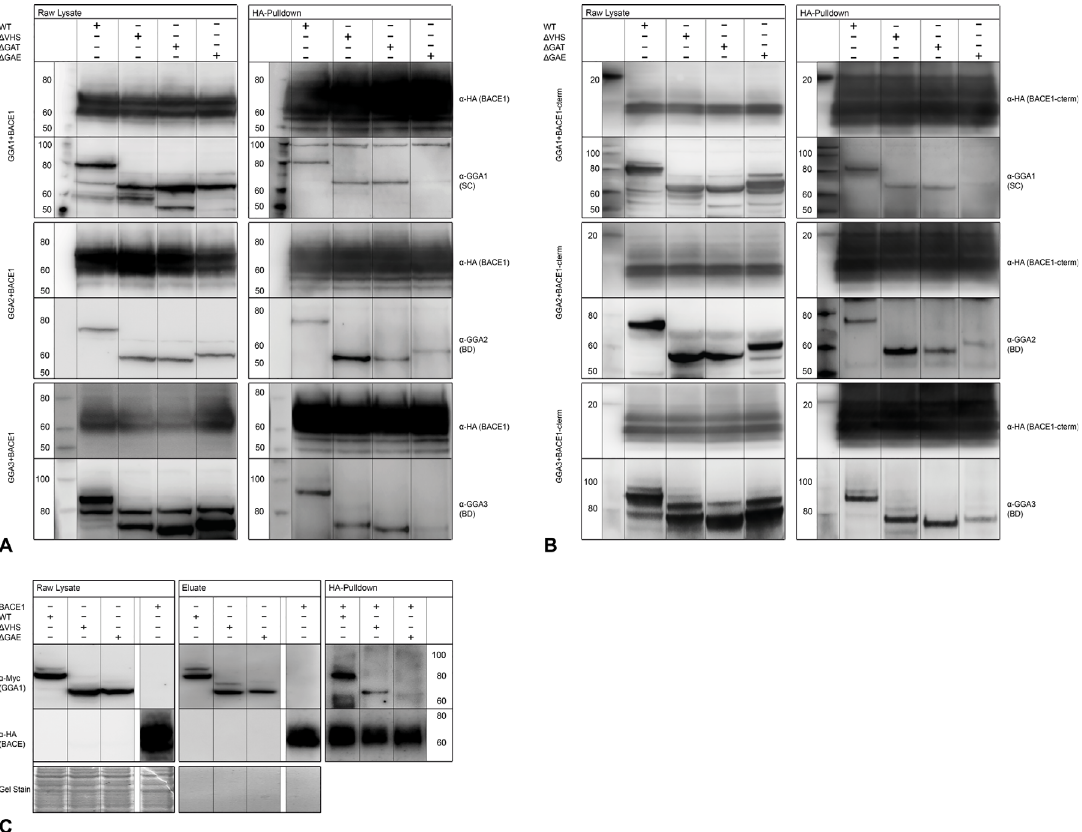
Fig 3. Deletion of GGA GAE domain but not VHS domain disrupts BACE1-GGA interaction in CoIPs. (A) HEK293 cells were co-expressed with BACE1-HA and either myc-tagged GGA_wt, - Δ VHS, - Δ GAT, or- Δ GAE constructs. Equal expression was controlled by Western blot (left panels). BACE1-HA was immunoprecipitated with anti-HA beads (Miltenyi Biotec), and precipitation and co-precipitation of the GGAs was controlled by Western blot (right panels). Deletion of the VHS domain of GGA 1, 2, or 3 did not disturb interaction with BACE1 compared with wt GGAs (Lanes 1+2). Likewise, deletion of the GAT domain had no effect on binding to BACE1 (Lane 3), whereas deletion of the GAE domain dramatically reduced binding of GGAs and BACE1 (Lane 4). (B) HEK293 cells were co-expressed with BACE1-cterm-HA and either myc-tagged GGA_wt, - Δ VHS, - Δ GAT, or- Δ GAE constructs. Equal expression was controlled by Western blot (left panels). BACE1-cterm-HA was immunoprecipitated with anti-HA beads (Miltenyi Biotec), and precipitation and co- precipitation of the GGAs was controlled by Western blot (right panels). Comparable to full-length BACE1, deletion of the VHS domain of GGA1, 2, or 3 did not disturb interaction with BACE1-cterm compared with wt GGAs (Lanes 1+2). Likewise, deletion of the GAT domain had no effect on binding to BACE1 (Lane 3), whereas deletion of the GAE domain dramatically reduced binding of GGAs and BACE1-cterm (Lane 4). (C) We tested whether BACE1 GGA1-GAE domain interaction is due to a direct binding of both proteins by using in vitro CoIP. Myc-tagged GGA1-wt, - Δ VHS, and- Δ GAE and HA-tagged BACE1 were expressed separately in HEK293 (left panel) and purified by immunoprecipitation using magnetic beads (Miltenyi Biotec) labeled with the corresponding antibodies (middle panel). Purified proteins were mixed and immunoprecipitated with anti-HA beads. Both GGA1-wt and GGA1- Δ VHS were co-precipitated by BACE1, but GGA1- Δ GAE was not, indicating direct binding of BACE1 and the GGA1-GAE